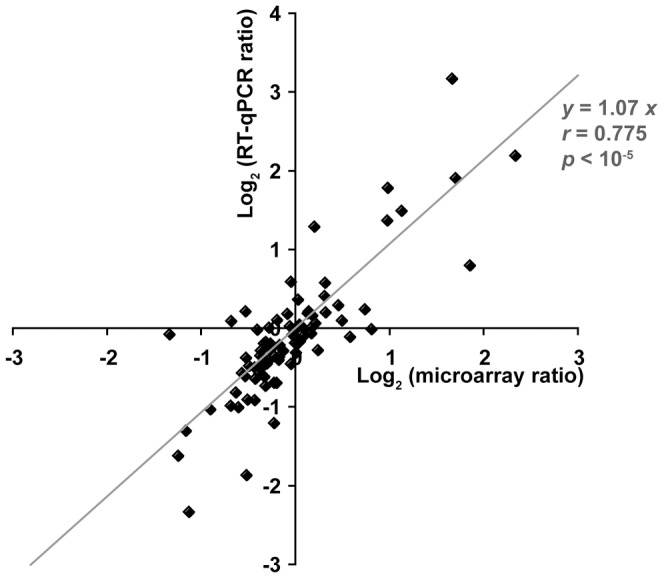
A plot of the RT-qPCR and microarray values.for the gene expression coefficient (log2 of ratios) for the 4 different comparisons (F HFD vs F CD, M HFD vs M CD, M CD vs F CD and M HFD vs F HFD) for 21 genes (Hsd11b1, Hsd11b2, Cxcl1, Prap1, Slc13a4, Slc22a3, Sult1e1, Tph1, Gcm1, Jarid1c, Suv39h1, Suv39h2, Dnmt3l, Maoa, C3, Pdgfß, Drd4, Vdr, Prl7a1, Gzmb, CD81). The RT-qPCR data correlated with the microarray data for most of the 84 coefficient, with a linear equation: y = 1.07x and a high correlation coefficient (r = 0.775). Spearman’s test indicated that this correlation was highly significant (p<10-5).